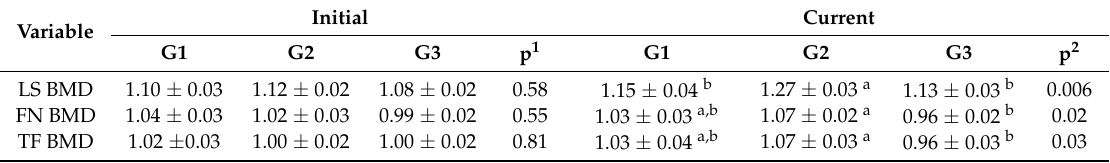
Table 2. Comparison of initial and current LS, FN, and TF BMD values between groups of participants. Initial Current Variable